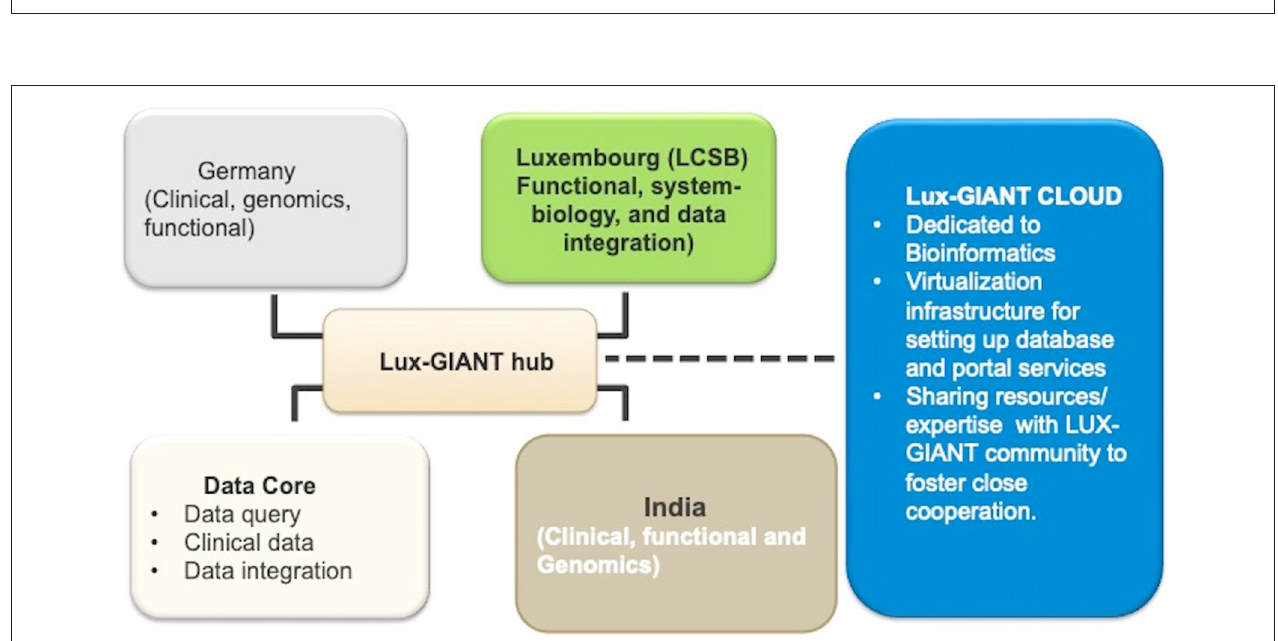
FIGURE 2 | Clinical, genomics, bioinformatics, and functional cores in the Lux-GIANT consortium.